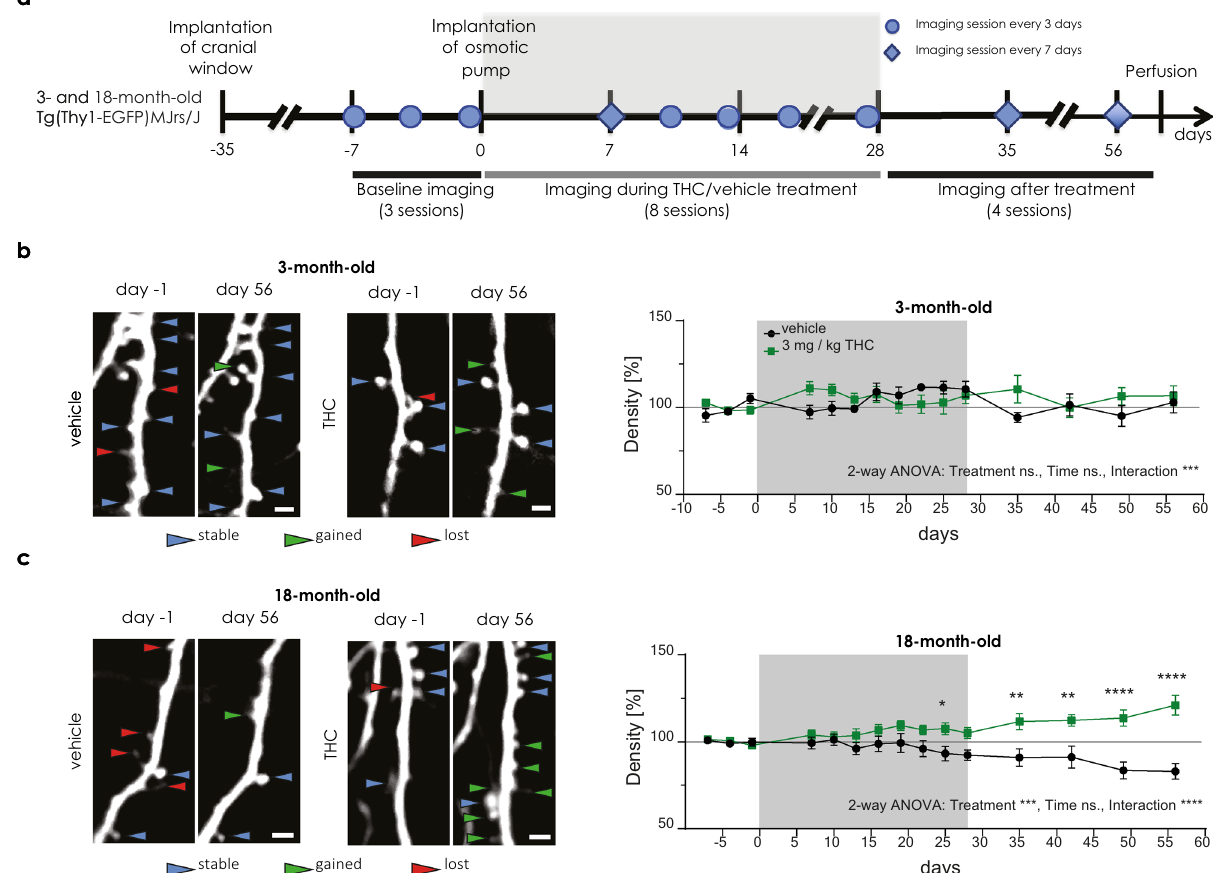
Figure 1. Long-term low-dose THC treatment increases spine density in old, but not in young mice. ( a ) Time line of the 2-photon imaging experiment. Representative images of the same dendritic segment at day -1 and day 56 acquired during in vivo imaging from 3- ( b ) and 18- ( c ) month-old mice treated with vehicle or THC. Scale bar is 2 µm. Spine density changes in 3- ( b ) and 18-month-old mice ( c ). Spine density was normalized to the mean spine density during baseline imaging. Grey box indicates the treatment duration. 3-month-old mice (THC n = 12 ROIs, N = 4 mice; vehicle n = 10 ROIs, N = 4 mice); interaction effect F 14,192 = 3.247, p = 0.0001; 18-month-old mice (THC n = 22 ROIs, N = 10 mice; vehicle group n = 17 ROIs, N = 8 mice) treatment effect F 1,37 = 13.04, p = 0.0009; interaction effect F 14,396 = 5.069, p < 0.0001 (day 25 p = 0.0141; day 35 p = 0.0036; day 42 p = 0.0035; day 48 and 56 p < 0.0001). THC effect in comparison to day -1 (day 35 p = 0.0093, day 42 p = 0.0008, day 49 p = 0.0064, day 56 p = 0.0007); vehicle effect in comparison to day -1 (day 56 p = 0.0322) (not shown on the graph). Error bars indicate mean ± SEM; 2-way ANOVA (Mixed-effects analysis) followed by Sidak’s multiple comparison test; * P < 0.05, ** P < 0.01; *** P < 0.001; **** P < 0.0001. ns. - not